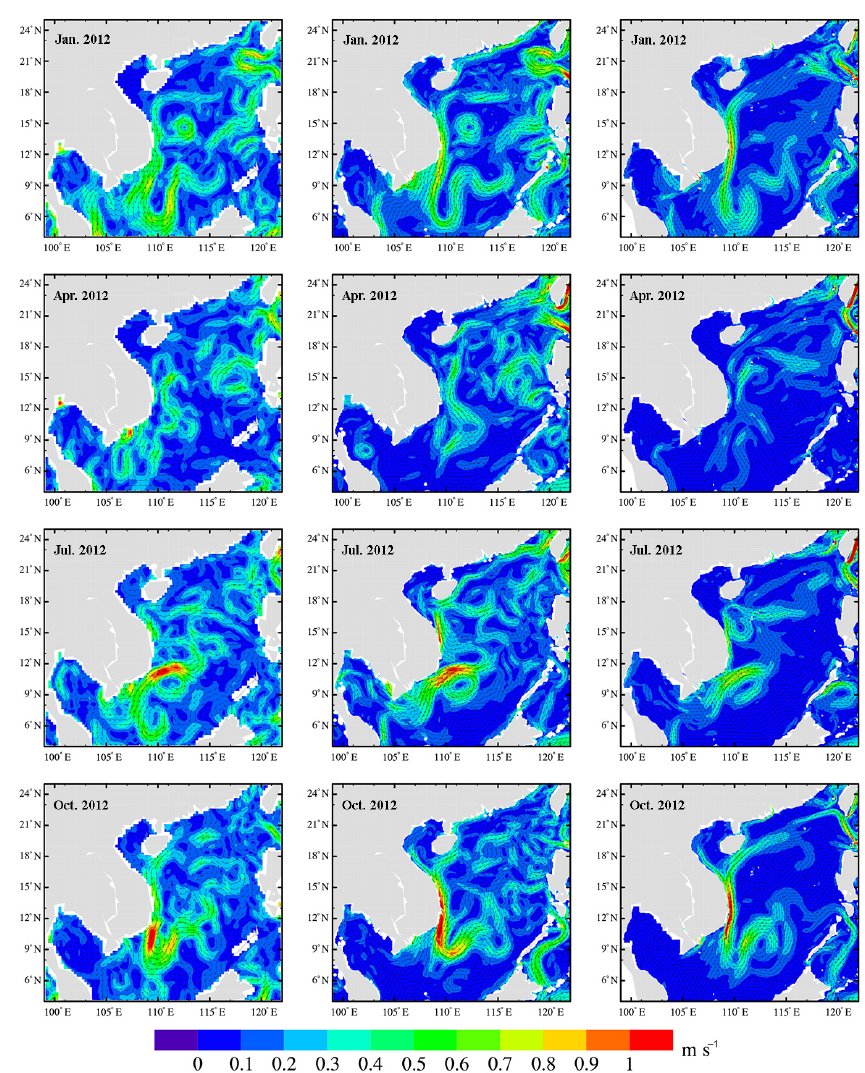
Figure 2. The monthly mean sea surface absolute geostrophic velocity (units: ms − 1 ) in January, April, July, and October 2012. The left panels are from AVISO, the middle panels are from Mercator Océan, and the right panels are from